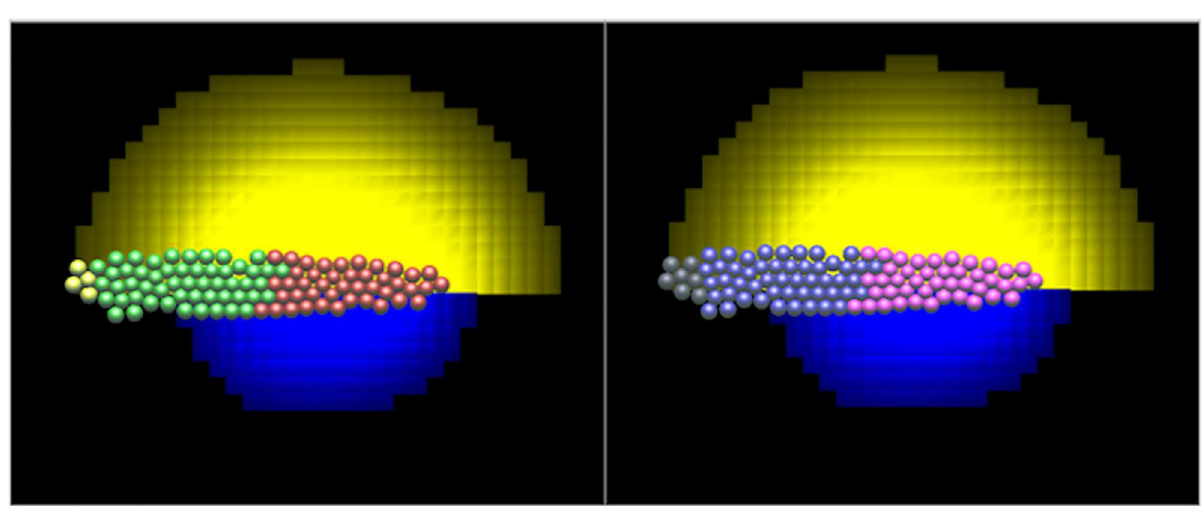
Fig 3. Illustration of the simulations using the 3D deformable ellipsoid cell-based model. View from above of a 1-cell layer representingthe PLLP. The stripe of CXCL12awouldbe directly underneaththe PLLP, not explicitlyshown. For visualizationpurposes, the Wnt (blue) and FGF (yellow)ligandsare shown as a pair of clouds in each split-image.Left panel: cells are coloredbased on receptor expressionlevel (red for high Wnt and green for high FGF receptor levels, W R , F R ). FGFR and WntR expressingcells are coloredyellow. Right panel:cells colored by their bound receptor levels (pink for high Wnt and purplefor high FGF bound-receptor levels, W B , F B ). In our model we interpret the latter as the Wnt or FGF signalling levels . Cells in the back of the PLLP express FGF receptors but do not signal since FGF ligandis so low that most FGF receptors are unbound. Grey or yellow cells at the back of the PLLP are those that are not yet committed to being either WntR or FGFR active cells. Results from the full 3D model after 30 min of simulationtime (before the onset of migration).